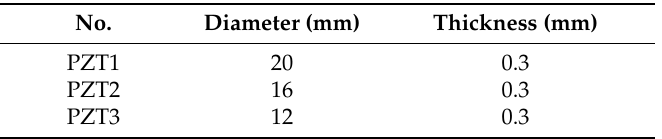
Table 1. Dimension of PZT wafers.